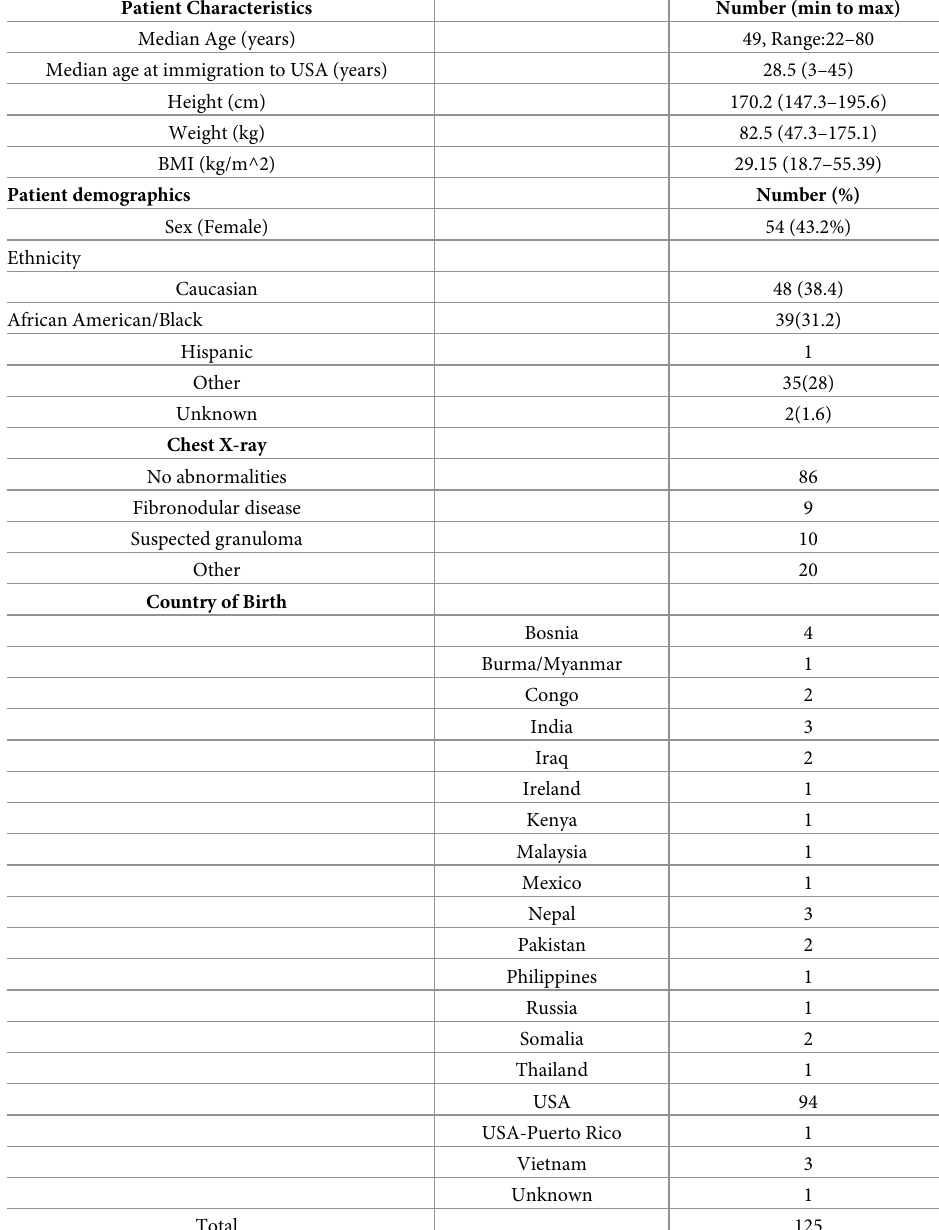
Table 1. Characteristics of patients with latent tuberculosis